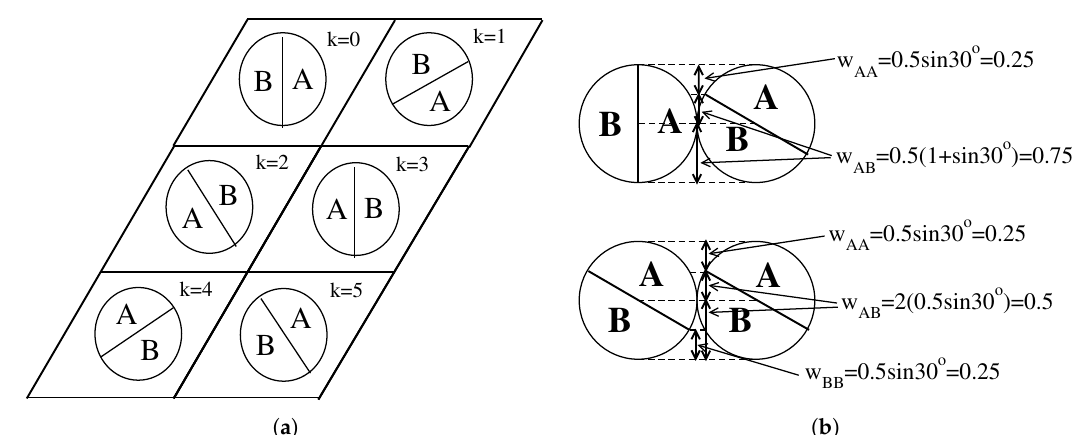
Figure 1. ( a ) The six possible orientations of a particle on a triangular lattice. ( b ) Two representative examples of differently oriented Janus particles, with ( k , l ) = ( 1,6 ) and ( 6,6 ) and the separation vector r = a 1 , demonstrating how the weights determining the interaction energy between neighboring particles were calculated.